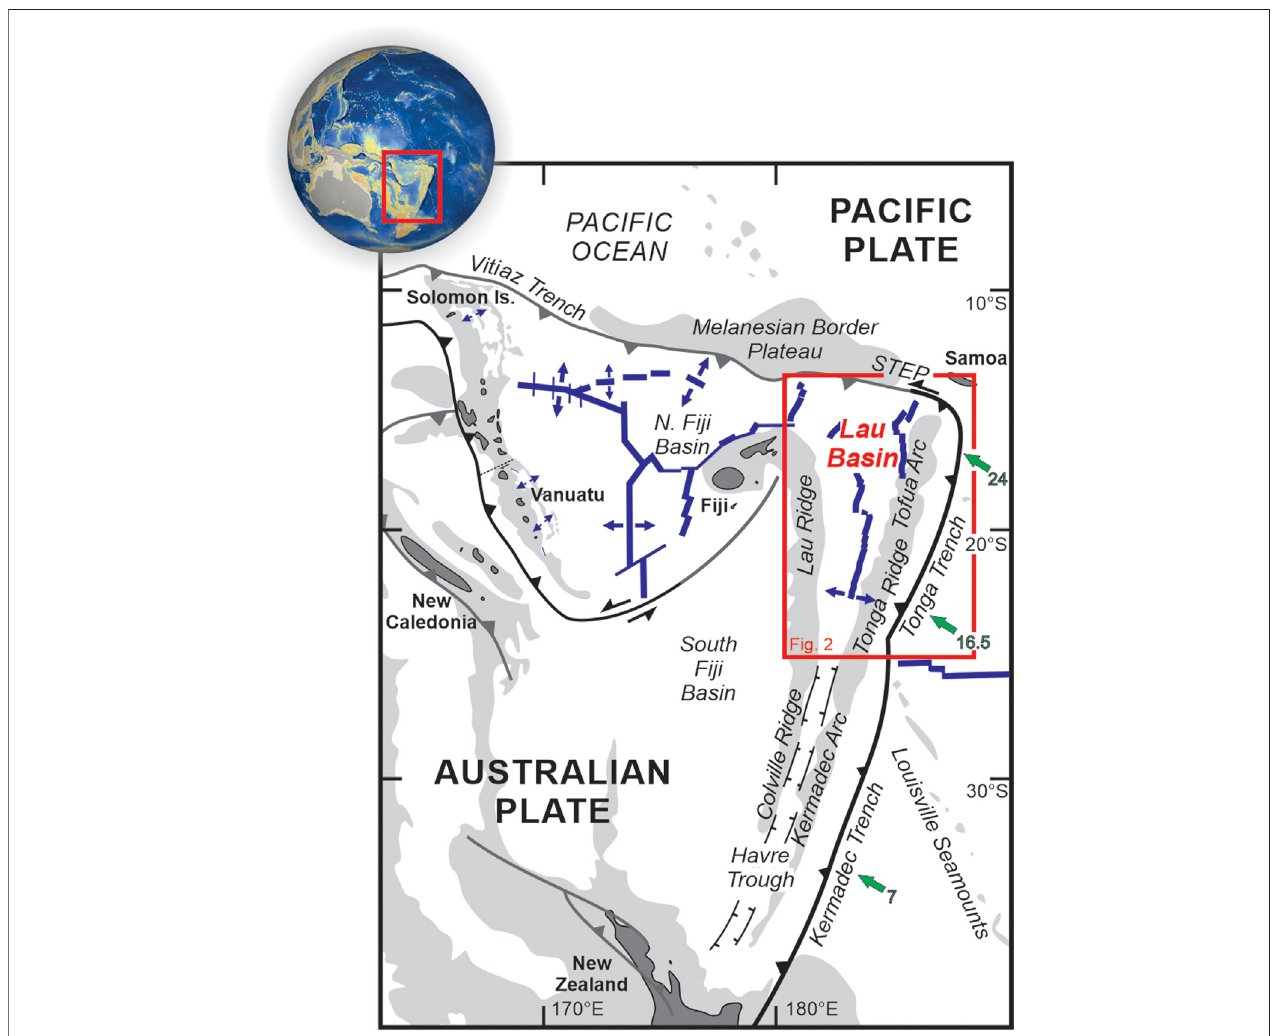
FIGURE 1 | Geographic location and tectonic features of the southwest Paci fi c modi fi ed from Hall (2002). Light gray areas represent the 2,000 m isobaths, green arrows indicate convergence directions and rates (cm/yr) from Bevis et al. (1995), and blue lines represent spreading centers. STEP, subduction-transform-edge- propagator